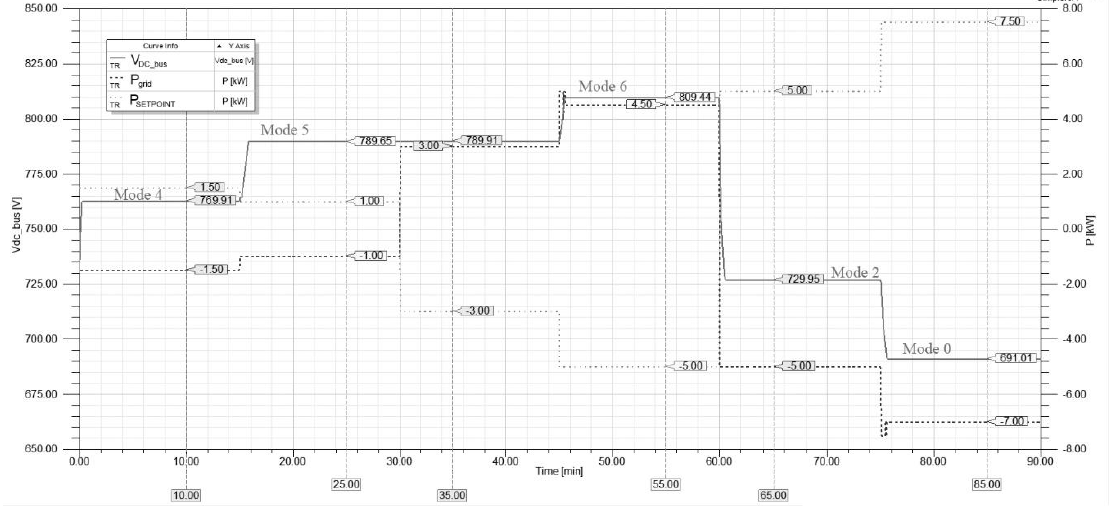
Figure 8. DC bus voltage of NG1, request of the aggregator (P setpoint ) and response from the NG1 (P grid ).